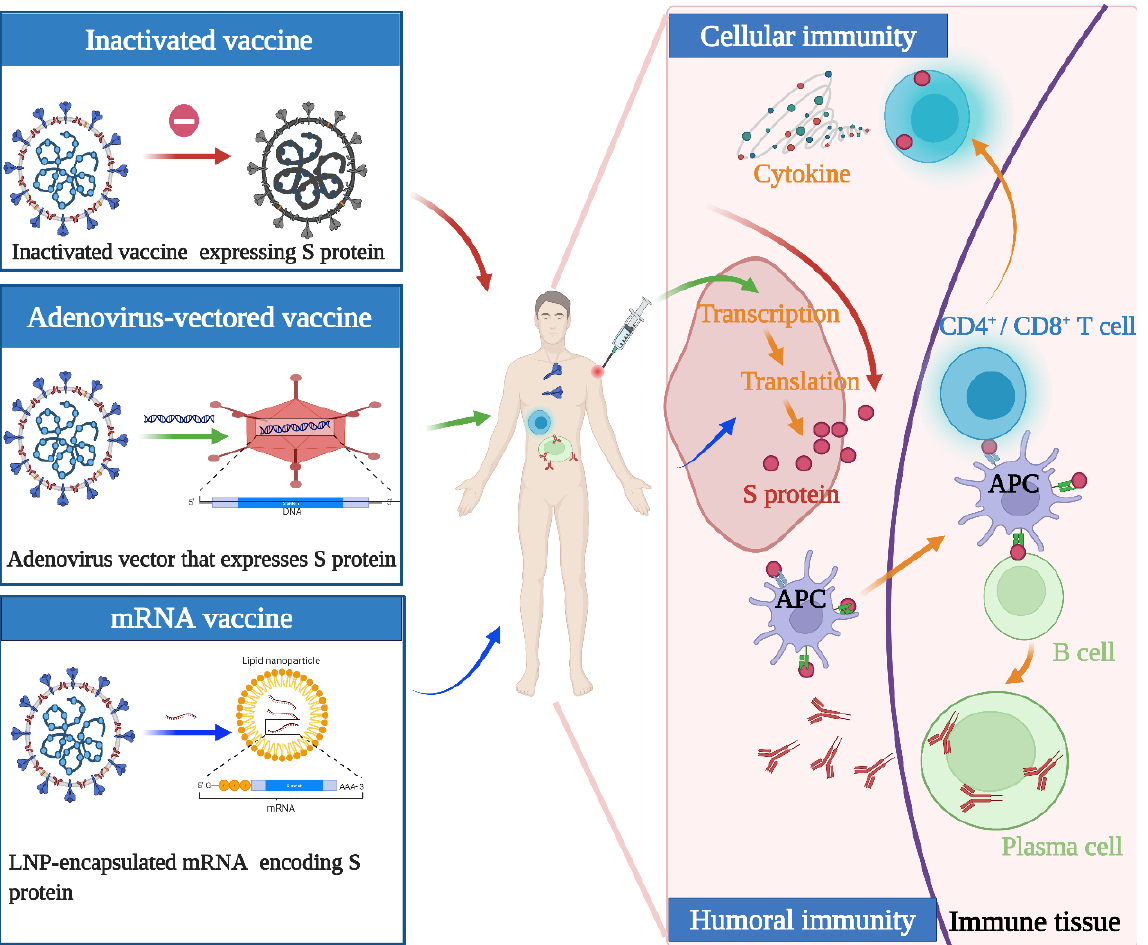
Figure 1. Illustration of the design and operation principles for different COVID-19 vaccines. Inacti- vated vaccines are inactivated but previously had virulent microorganisms that have been destroyed with chemicals, heat, or radiation. Adenovirus-vectored vaccines are recombinant vaccines formu- lated by combining the replication-deficient adenovirus vector and the target DNA. mRNA vaccines are a novel type of vaccine that works by injecting genetically engineered vectors containing RNA sequences encoding specific antigens. They function by activating cellular and humoral immunity to varying